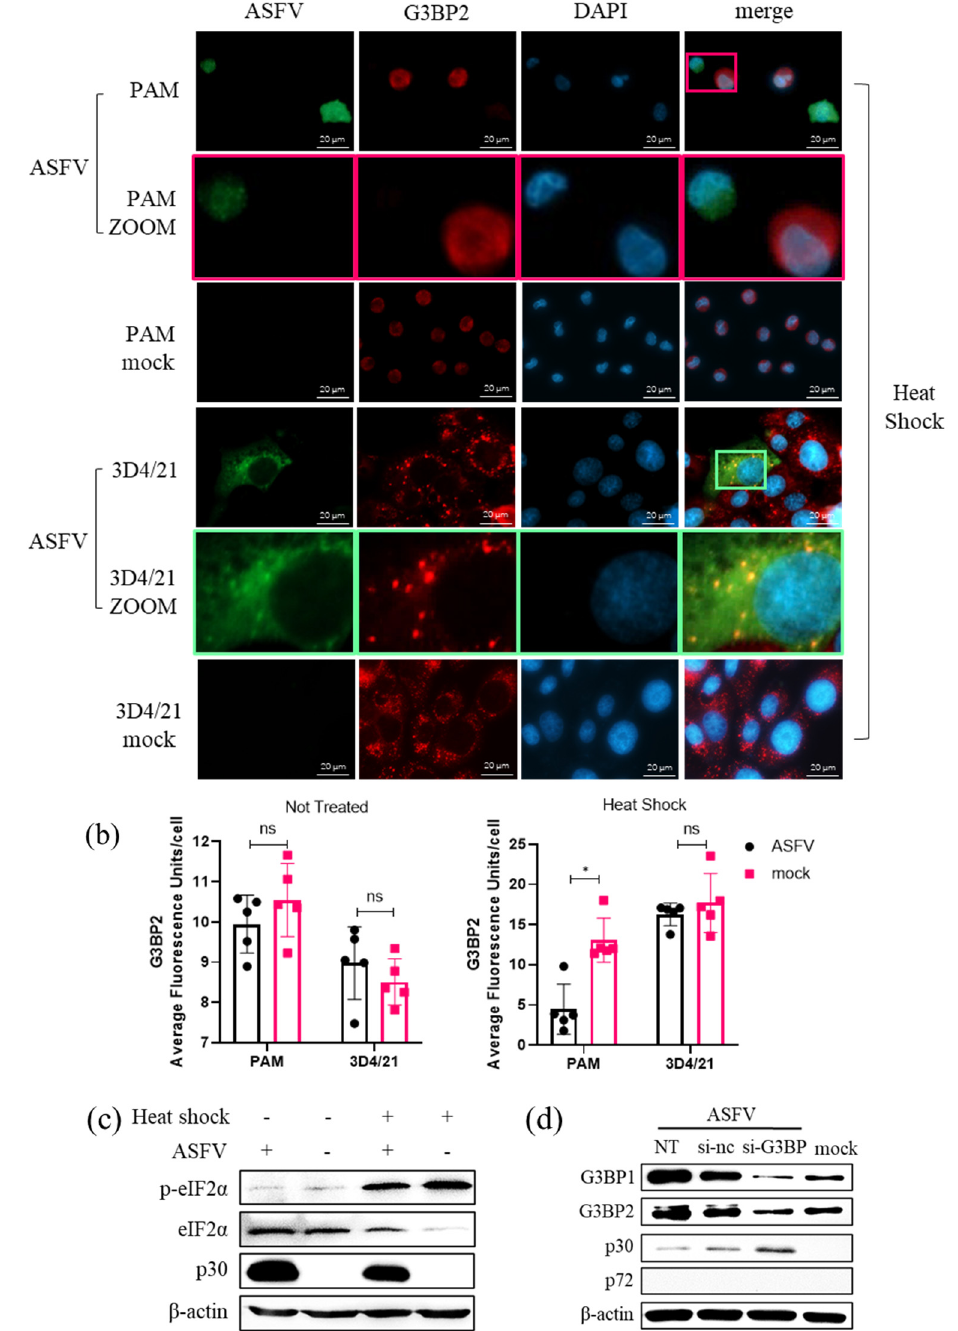
Figure 8. SG formation in the different cells. ( a ) The cells were infected with ASFV at 5 MOI and heat − shocked for 20 min at 50 °C or not treated before fixation at 24 hpi with 4% PFA. ASFV was labeled by p30 protein, SG formation was labeled by G3BP2. Colored squares indicate corresponding zoom views. ( b ) G3BP2 fluorescence intensity in ASFV-infected or mock cells quantified with ImageJ. ns: no significant difference by t -test; *, p < 0.05. ( c ) Effect of SG formation on ASFV infection in PAMs. PAMs were infected with ASFV at 5 MOI and collected at 24 hpi after heat shock or no treatment. Phosphorylation of eIF2 α and viral p30 protein was detected by western blot. ( d ) Effect of SG formation on ASFV infection in 3D4/21 cells. 3D4/21 cells were transfected with siRNAs against G3BP1/2 (si − G3BP), negative control (si − nc) or not transfected (NT) for 12 h before infected with ASFV at 5 MOI and collected at 48 hpi. Expression of G3BP1, G3BP2, viral p30 and p72 proteins was detected by western blot.